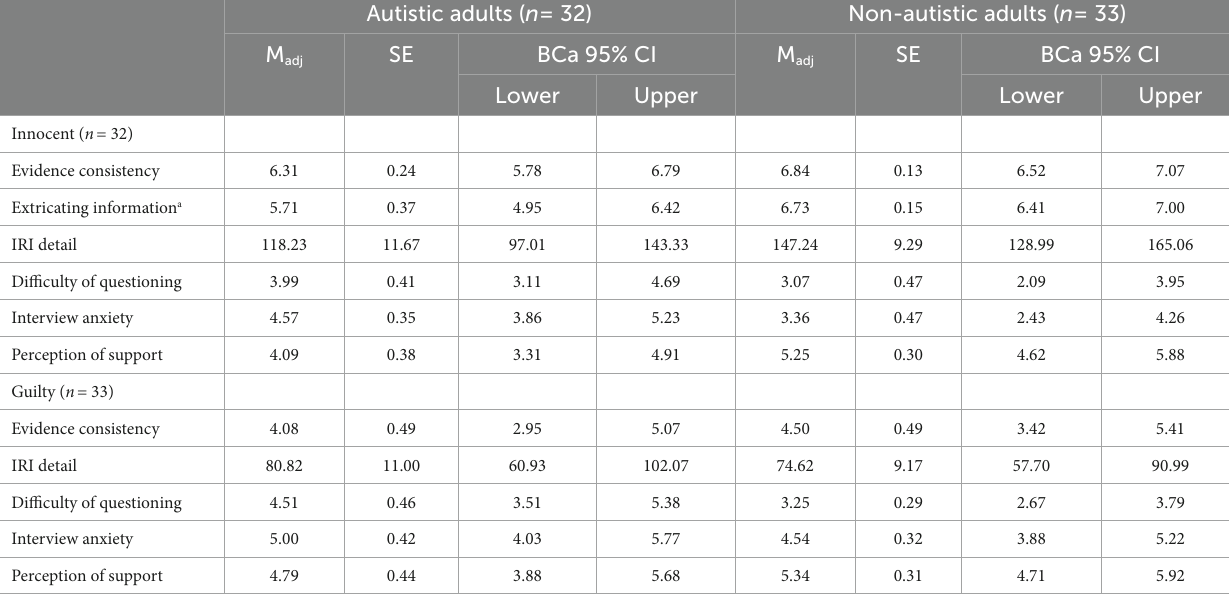
TABLE 3 Autistic and non-autistic group estimated mean scores for interview performance and